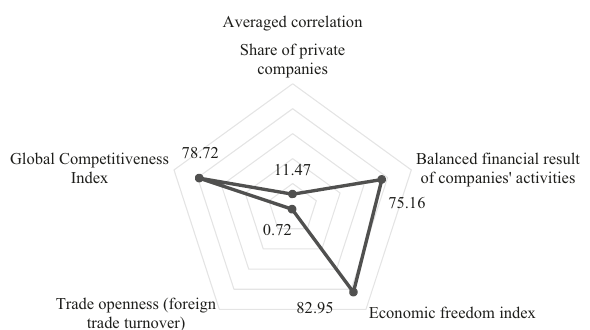
Fig. 5 Averaged correlation between Russian ‘ capitalism 4.0 ’ and the indicators for the digital society (%). Source: Calculated by the authors.